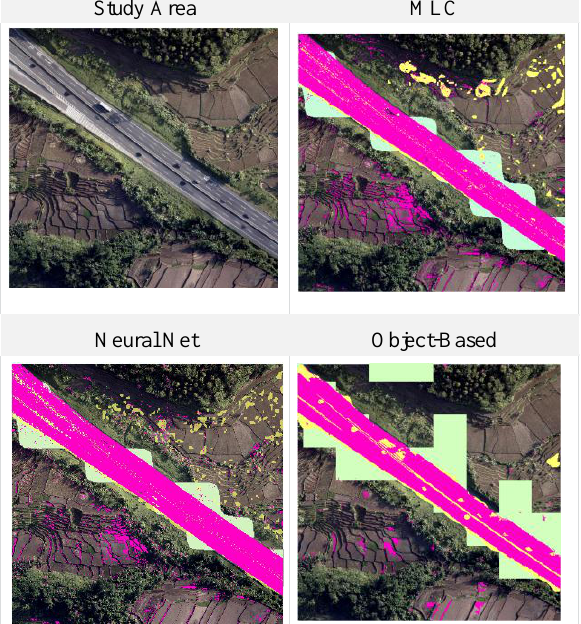
Figure 5. Pattern consistency for highway feature that retrieved from several data with several digital classification methods